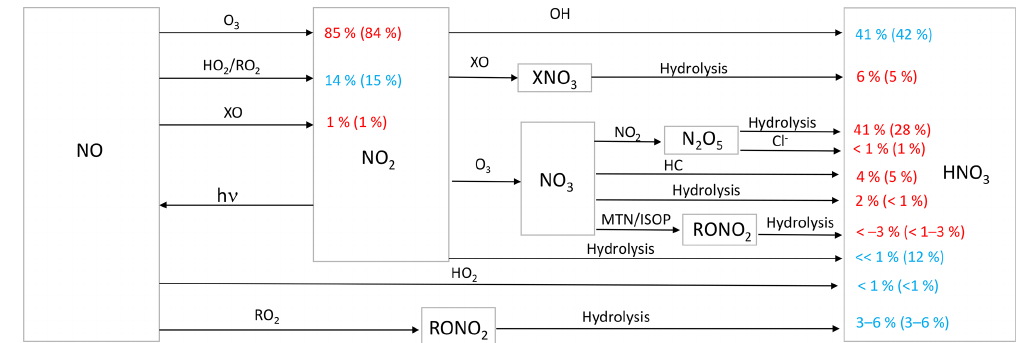
Figure 1. Simplified HNO 3 formation in the model. Numbers show the global annual-mean percent contribution to NO 2 and HNO 3 formation in the troposphere below 1km for the cloud chemistry (standard) simulation. Red indicates reactions leading to high (cid:49) 17 O values, and blue indicates reactions leading to low (cid:49) 17 O values. HO 2 = HO 2 + RO 2 ; X = Br + Cl + I; HC: hydrocarbons; MTN: monoterpenes; ISOP: